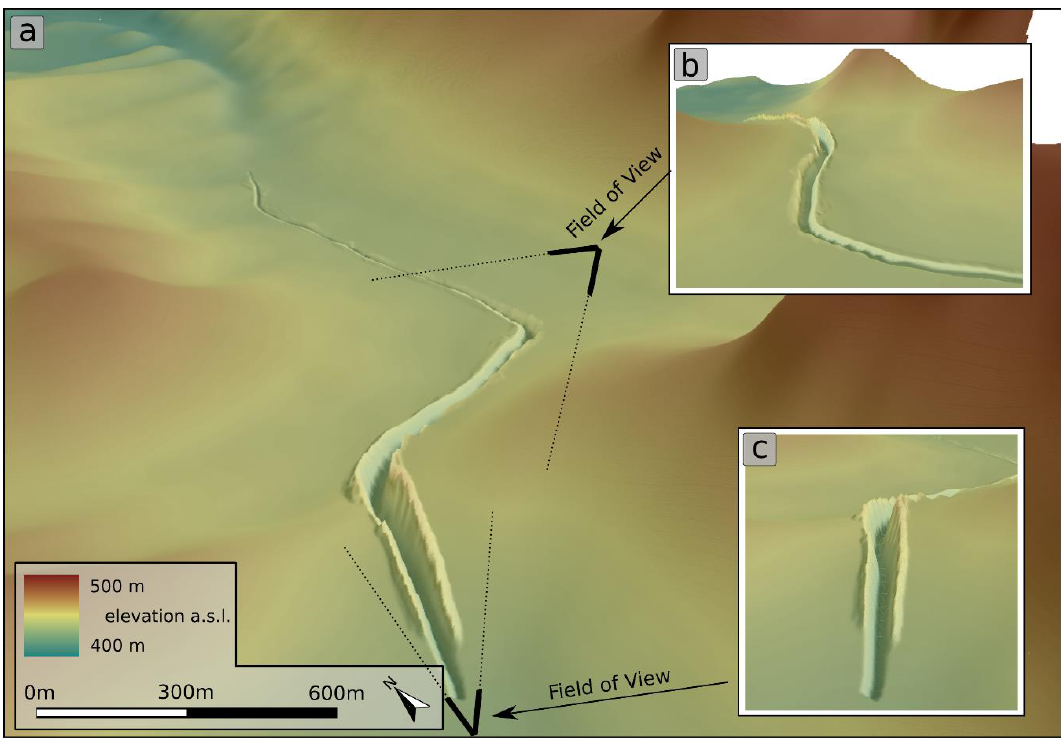
Figure 10. 3D-model of the Fossa Carolina with surrounding pre-modern topography and present remnants of the dams. The 3D-model is 15x exaggerated and its representation method is “perspective”. ( a ) Entire canal course with a view from southeast, ( b ) enlarged section of the prominent bend between the West-East and Northern Section, ( c ) enlarged section of the Central Section.